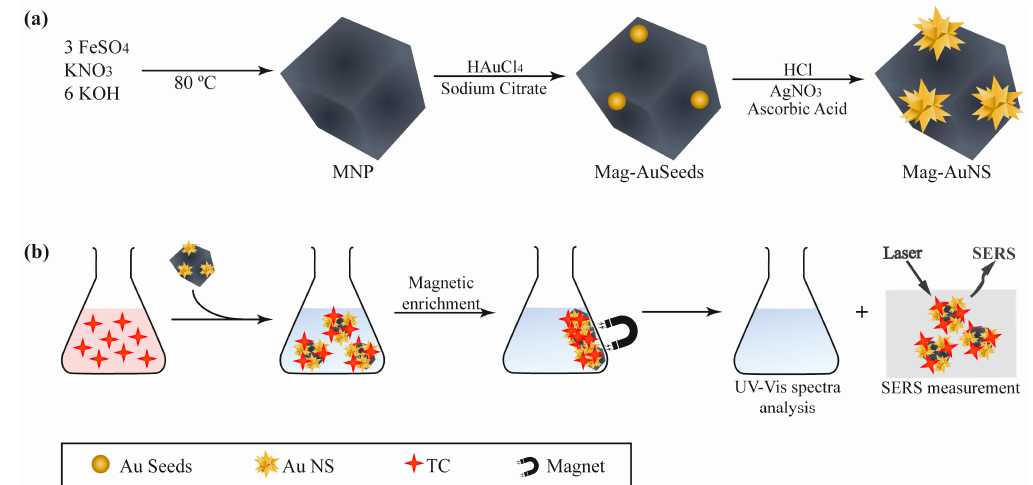
Figure 1. Schematic illustration of the ( a ) preparation of magnetite-gold nanostars (MNP-AuNS) hybrid materials; and ( b ) operating procedure for the magnetic uptake and surface-enhanced Raman scattering (SERS) detection of tetracycline (TC), using MNP-AuNS.